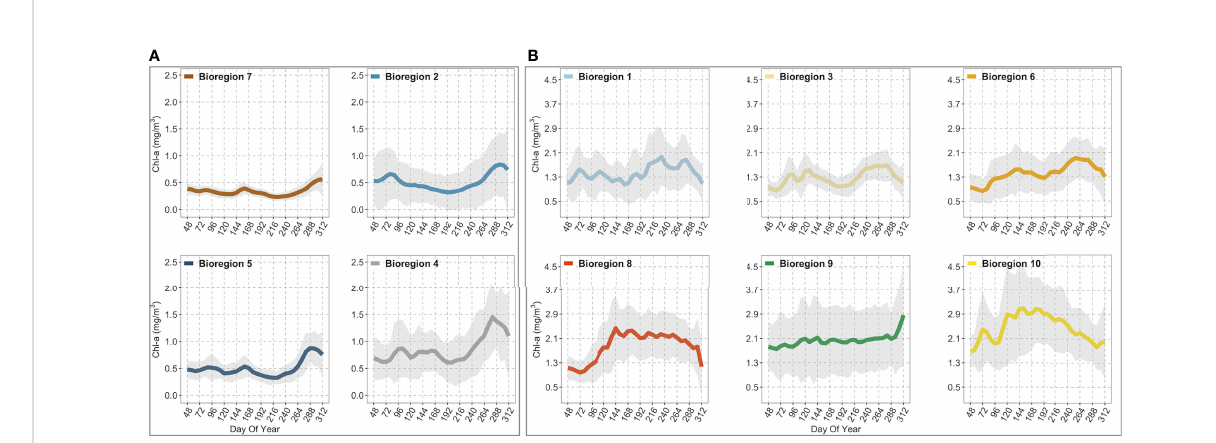
FIGURE 6 Figure showing the climatological seasonal cycles of chlorophyll-a (thicker colored lines) for each bioregion. (A) contains the four (i.e., #2, 4, 5, 7) off-shelf/shelf-break bioregions. (B) contains the six (i.e., #1, 3, 6, 8, 9, 10) neritic bioregions. The shaded areas represent the standard deviation (± SD). The seasonal cycles were obtained from 8-day composites of Sentinel-3 data over 5 years (2016-2020) spatially averaged over bioregions shown in Figure 5. The day of the year (DOY) is reported on the x-axis, while chlorophyll-a concentrations (mg/m 3 ) are reported on the y-axis on different scales, depending on the box. Note that each color corresponds to that used in Figure 5 and identi fi es the same